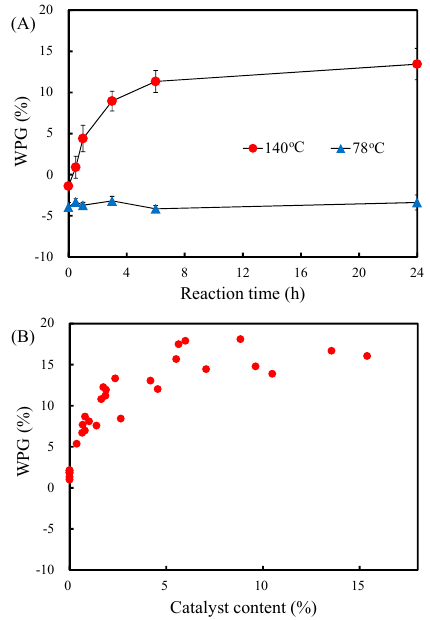
Figure 1. ( A ) The weight percent gain (WPG) of vinyl acetate (VA)-acetylated slicewood reacted at 78 °C and 140 °C as a function of reaction time. Values are mean ± standard deviation (SD) ( n = 9); ( B ) Effect of potassium carbonate content on the WPG of VA-acetylated slicewood by the reaction at 140 °C for 6 h.